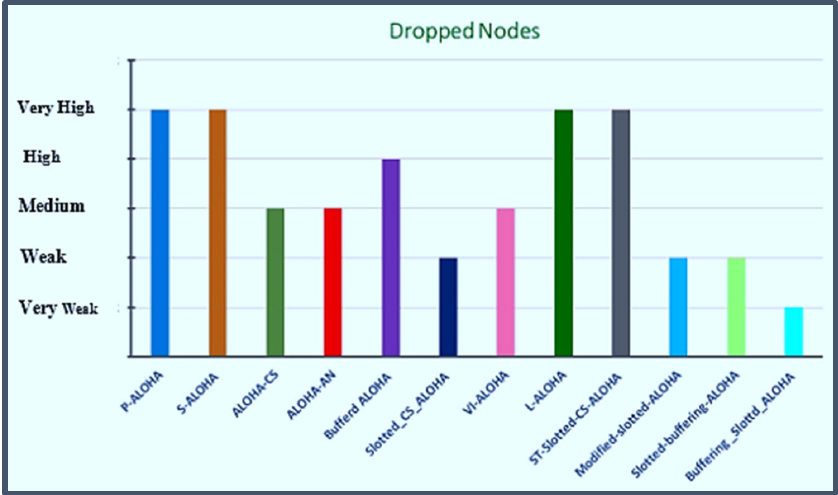
Figure 9. Comparison of dropped nodes between different ALOHA protocols.